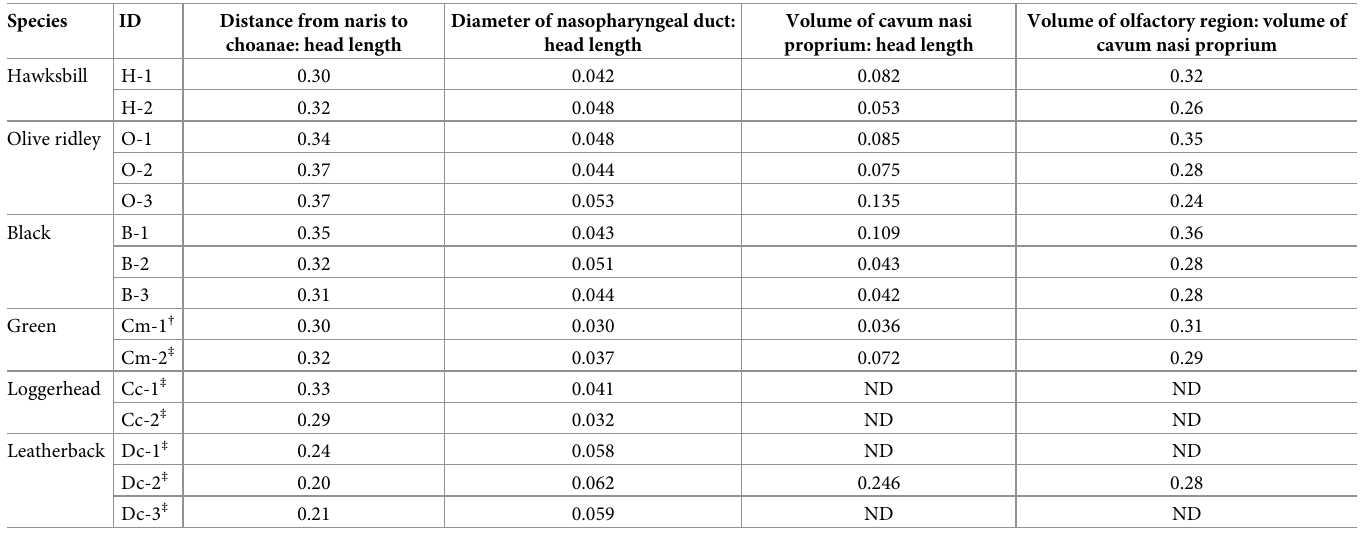
Table 3. Indicators of the nasal morphology analyzed in this study. Species